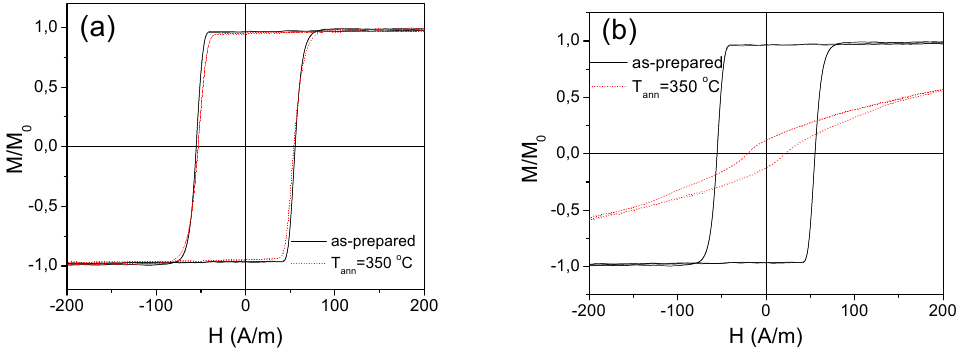
Figure 13. Hysteresis loops of as-prepared and annealed at T ann = 350 °C for σ a = 0 MPa Fe 75 B 9 Si 12 C 4 sample ( a ) and annealed at the same T ann for σ a = 190 MPa Fe 75 B 9 Si 12 C 4 sample ( b ).